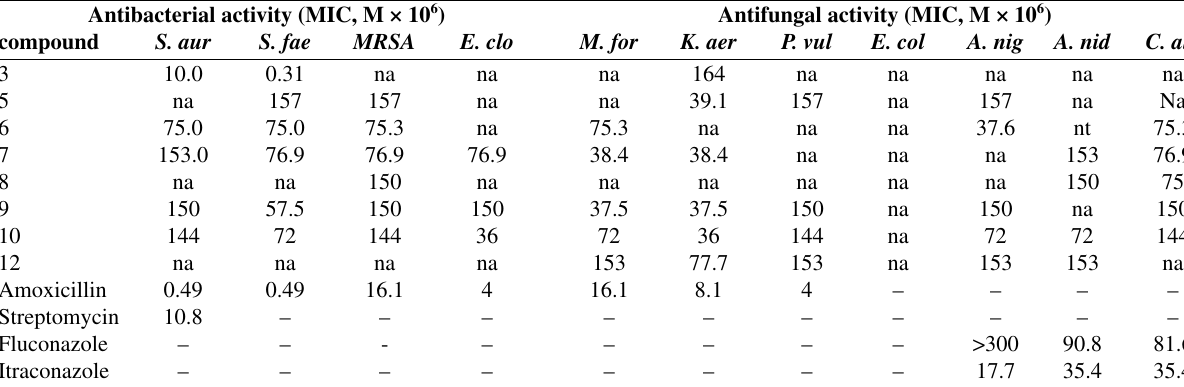
Table 1. Antibacterial and antifungal activity of selected compounds Antibacterial activity (MIC, M × 10 6